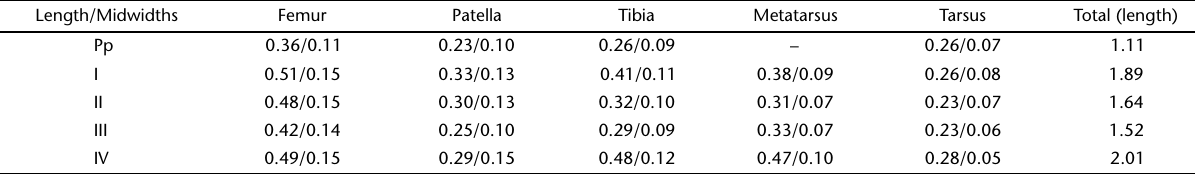
Table II. Masteria manauara sp. nov. Female paratype (INPA 8600). Length and midwidths of right legs and palpal segments.